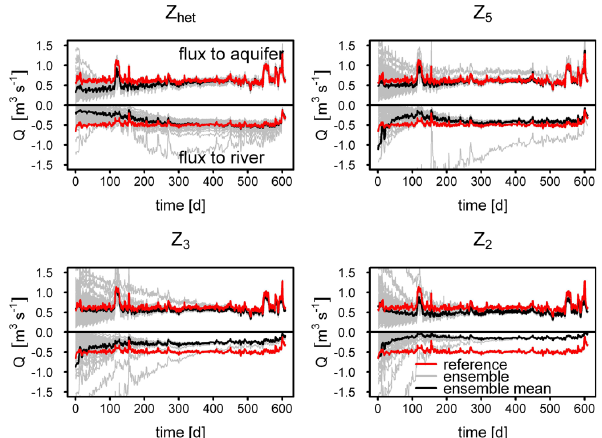
Fig. 7. Cumulative directional fluxes between river and aquifer for conditional simulations with EnKF for four representations of spa- tial heterogeneity (scenario A). Results are shown for reference I. Fluxes from river to aquifer have a positive